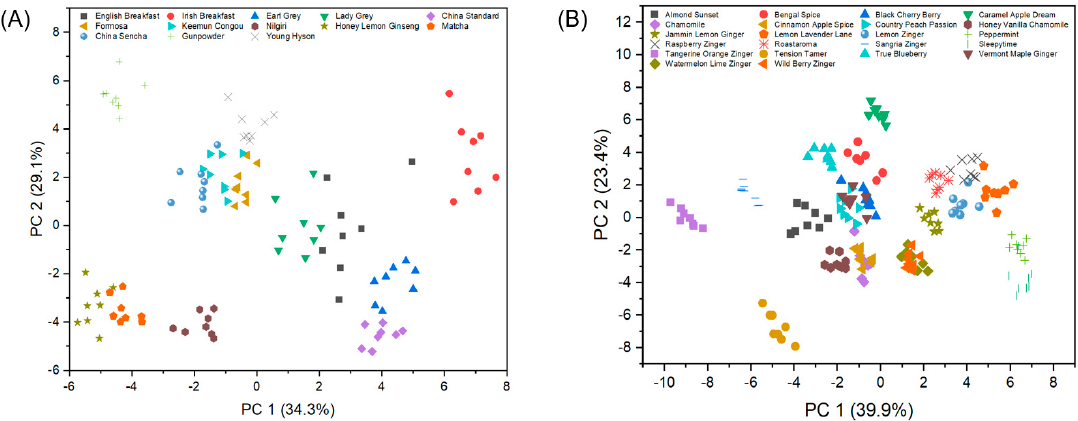
Figure 4. PCA plots of ( A ) eight black teas and five green teas, and ( B ) 22 herbal teas analyzed with the same sensor chip using four types of monolayer protected nanoparticles.